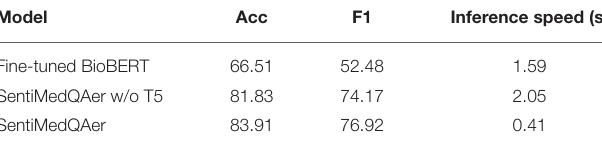
TABLE 9 | Ablation study.